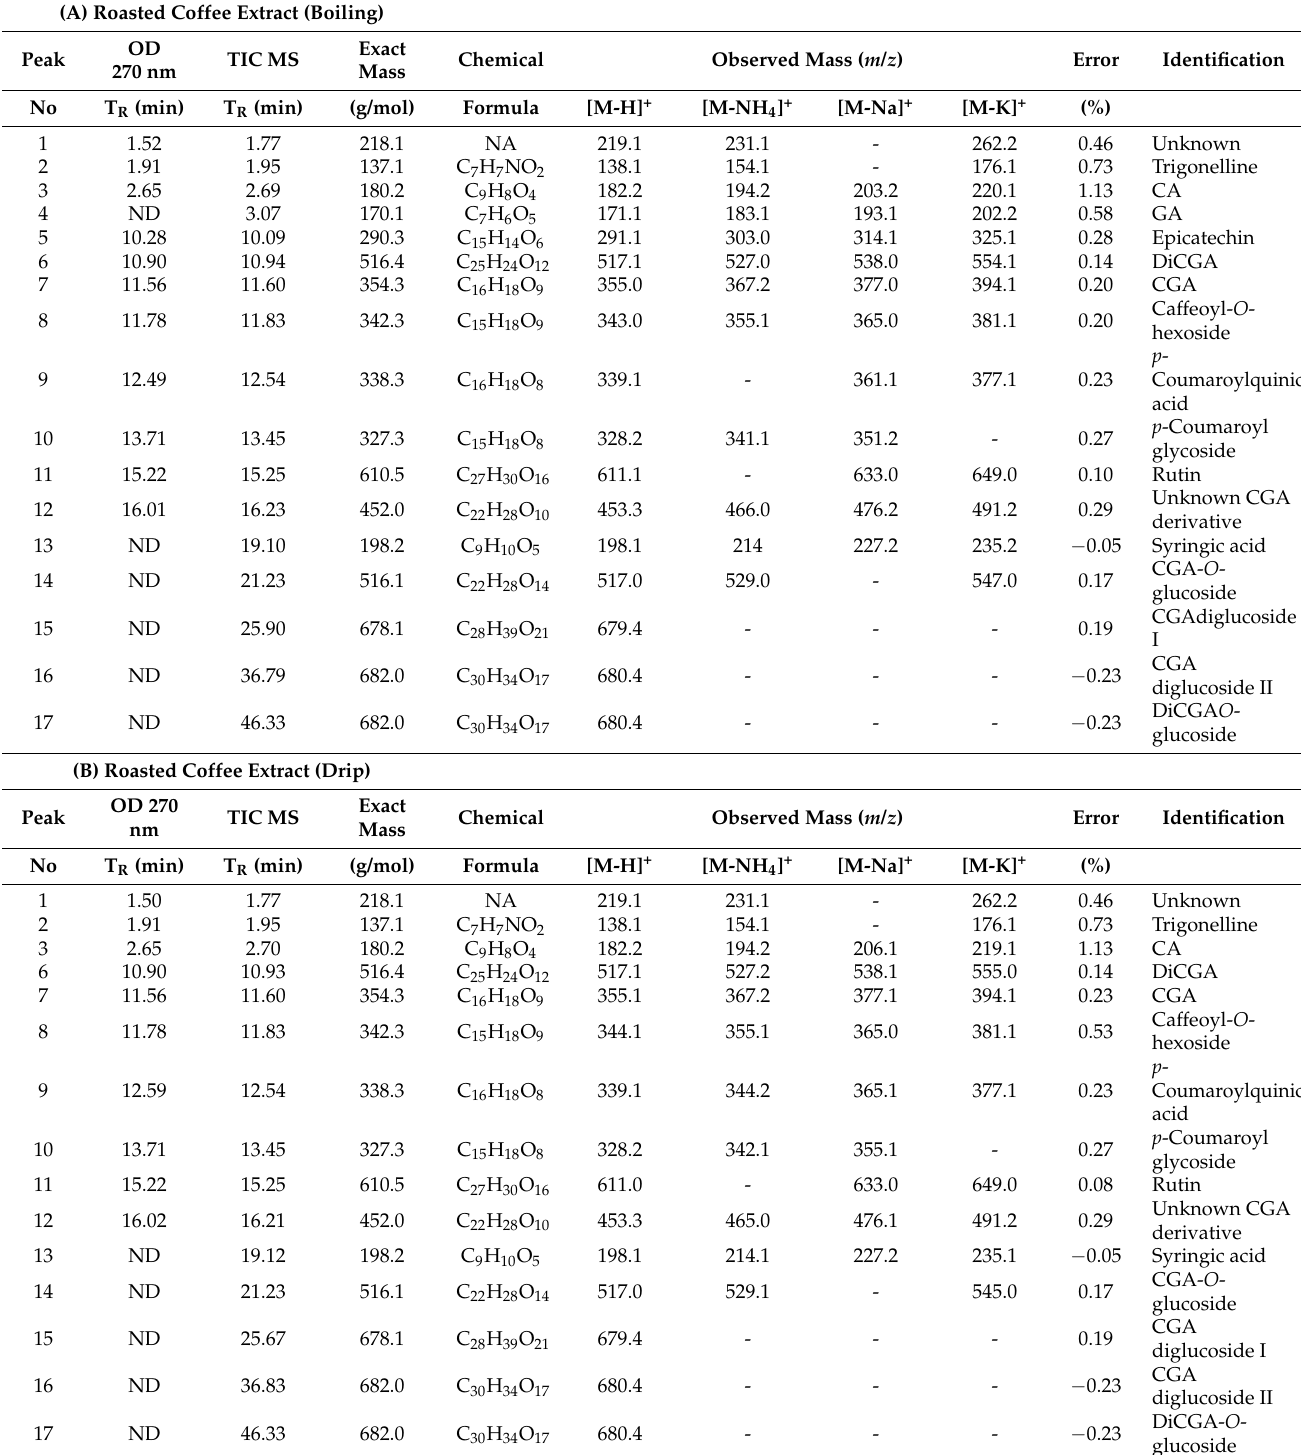
Table 2. Identification of phenolic compounds in roasted and green coffee extracts. Roasted and green coffee were extracted using the boiling, drip and espresso methods. Phenolic compounds in the coffee extracts were identified using HPLC-ESI-MS, as has been described in Section